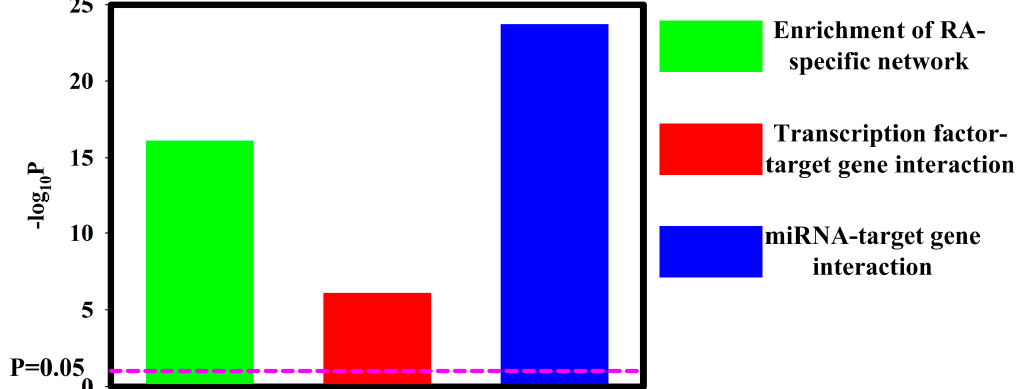
Figure 2. Interaction analysis of transcription factors, miRNA, and target genes. TFmiR analysis revealed significant enrichment of RA-specific network ( p = 8.48 × 10 − 17 ). Significant transcription factor–target gene interaction (8.30 × 10 − 7 ) and miRNA–target gene interaction (2.03 × 10 − 24 ) were revealed.